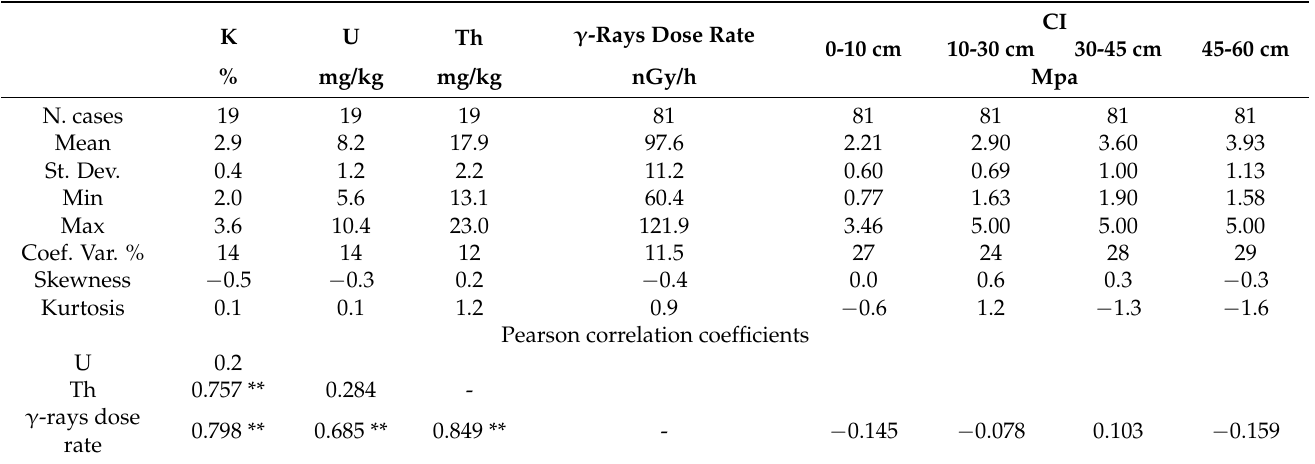
Table 2. Descriptive statistics of γ -rays dose rate and penetrometry survey (Cone index (CI)) data at different depths (0–10, 10–30, 30–45